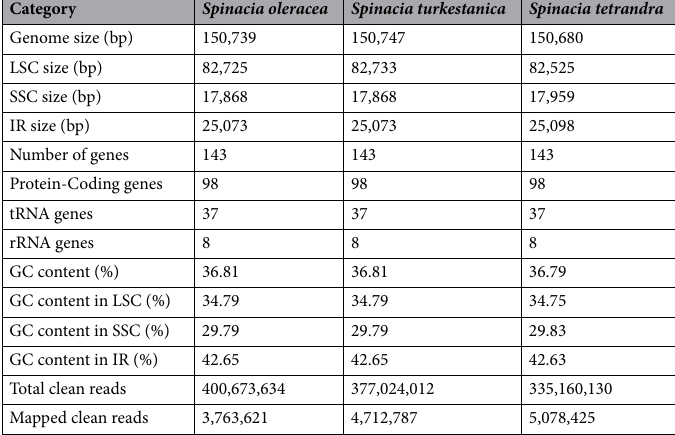
Table 1. Summary of the three Spinacia species chloroplast